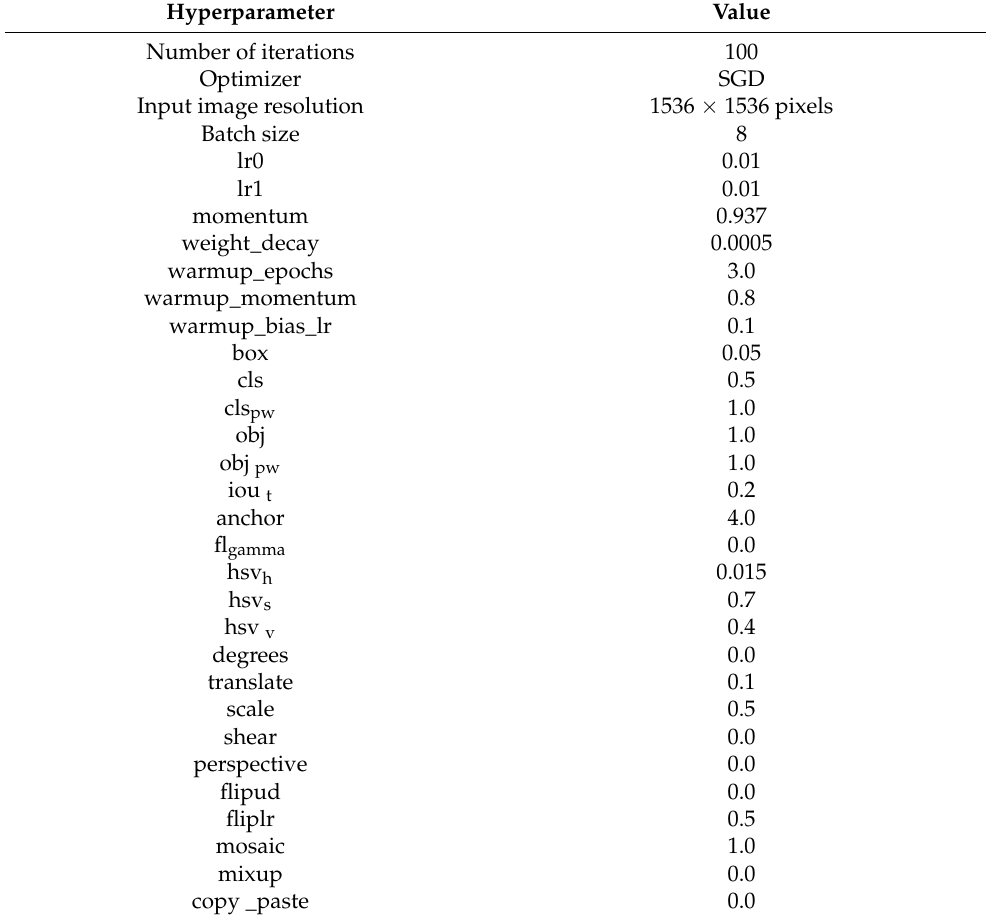
Table 4. YOLOv5 hyperparameters.